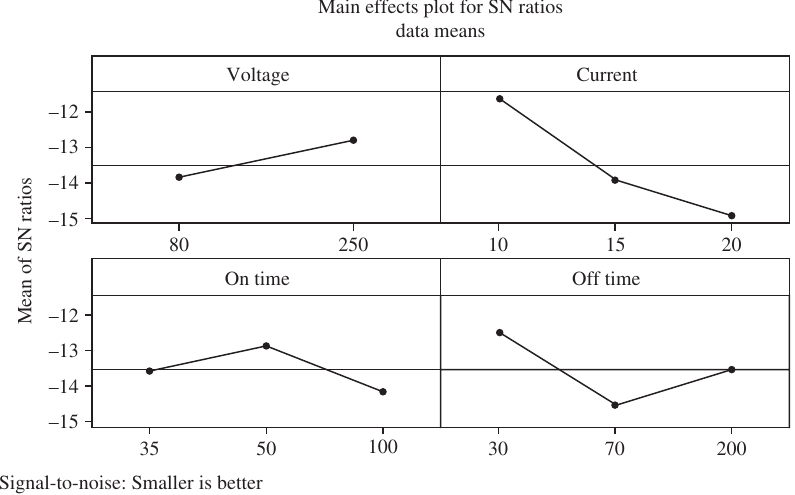
Figure 4: Effects of the input parameters of EDM on SR in the machining of 2024 alloy.